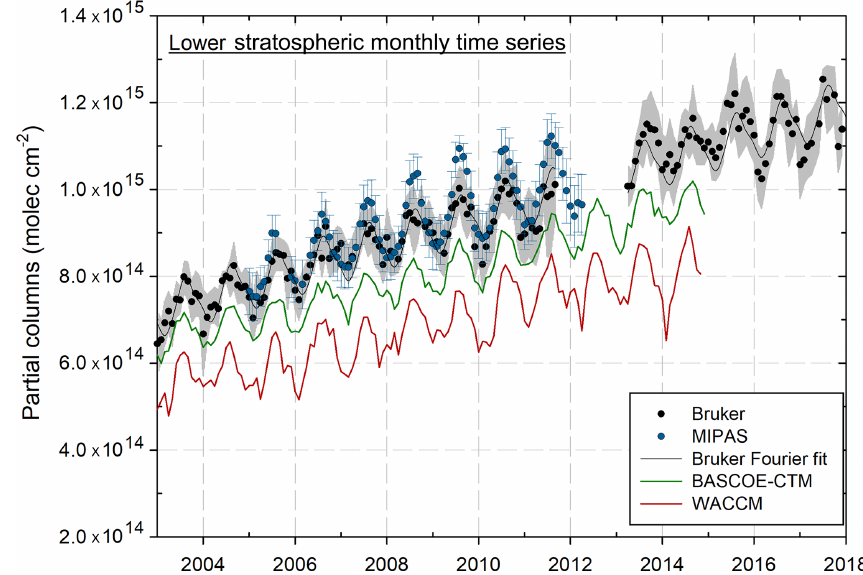
Figure 4. Time series of lower-stratospheric partial columns (11.21–30km, as defined by the retrieval information content) above Jungfrau- joch (MIPAS at ± 5 ◦ latitude around JFJ). The grey shaded area and the blue vertical bars depict the standard deviation around the FTIR and the MIPAS monthly means, respectively. A Fourier series fitted to the Bruker time series (black curve) is also represented (see Sect. 5). FTIR partial columns from the middle of 2011 to the middle of 2013 are not displayed because of the lower quality retrievals observed during this time period (see Sect.